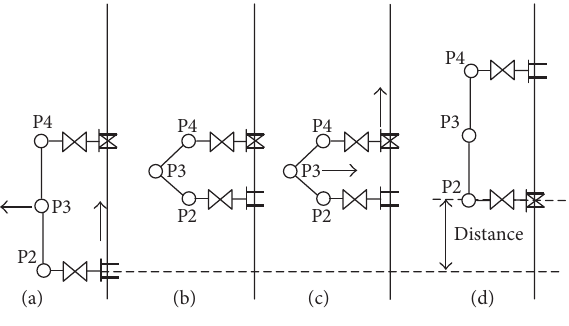
Figure 7: The gait for inchworm